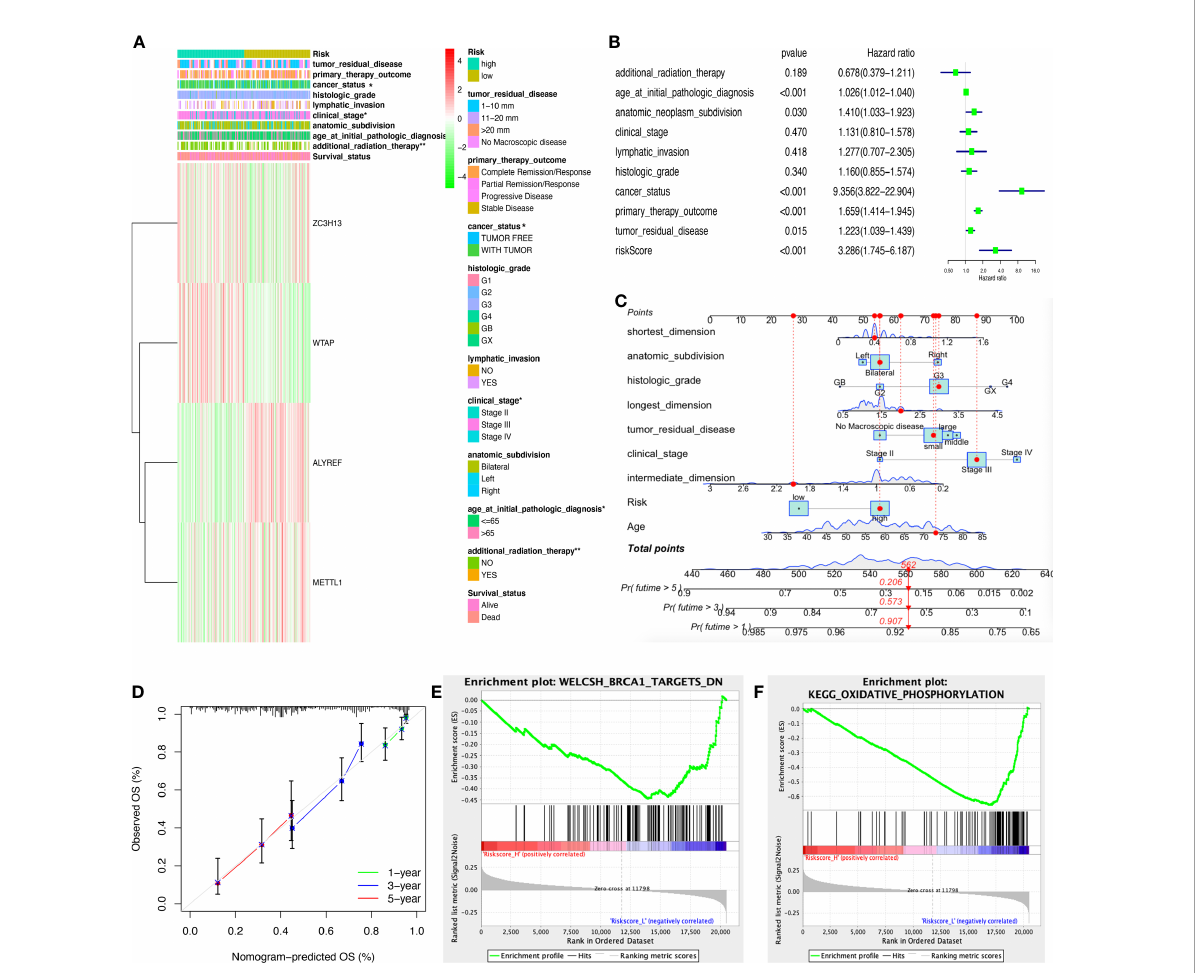
FIGURE 6 Clinical correlation between high- and low-riskscore groups. (A) The clinical heatmap between high- and low-riskscore groups. (B) The univariate Cox regression analysis of risk factors in ovarian cancer. (C) The risk score assessment nomogram to evaluate prognosis in ovarian cancer (1-, 3-, and 5-year survival rates). (D) The decision-making tree plot of nomogram. (E) GSEA plot of WELCSH_BRCA1_TARGETS_DN between high and low riskscore groups. (F) GSEA plot of KEGG_OXIDATIVE_PHOSPHORYLATION between high and low riskscore groups. *p < 0.05 and **p <